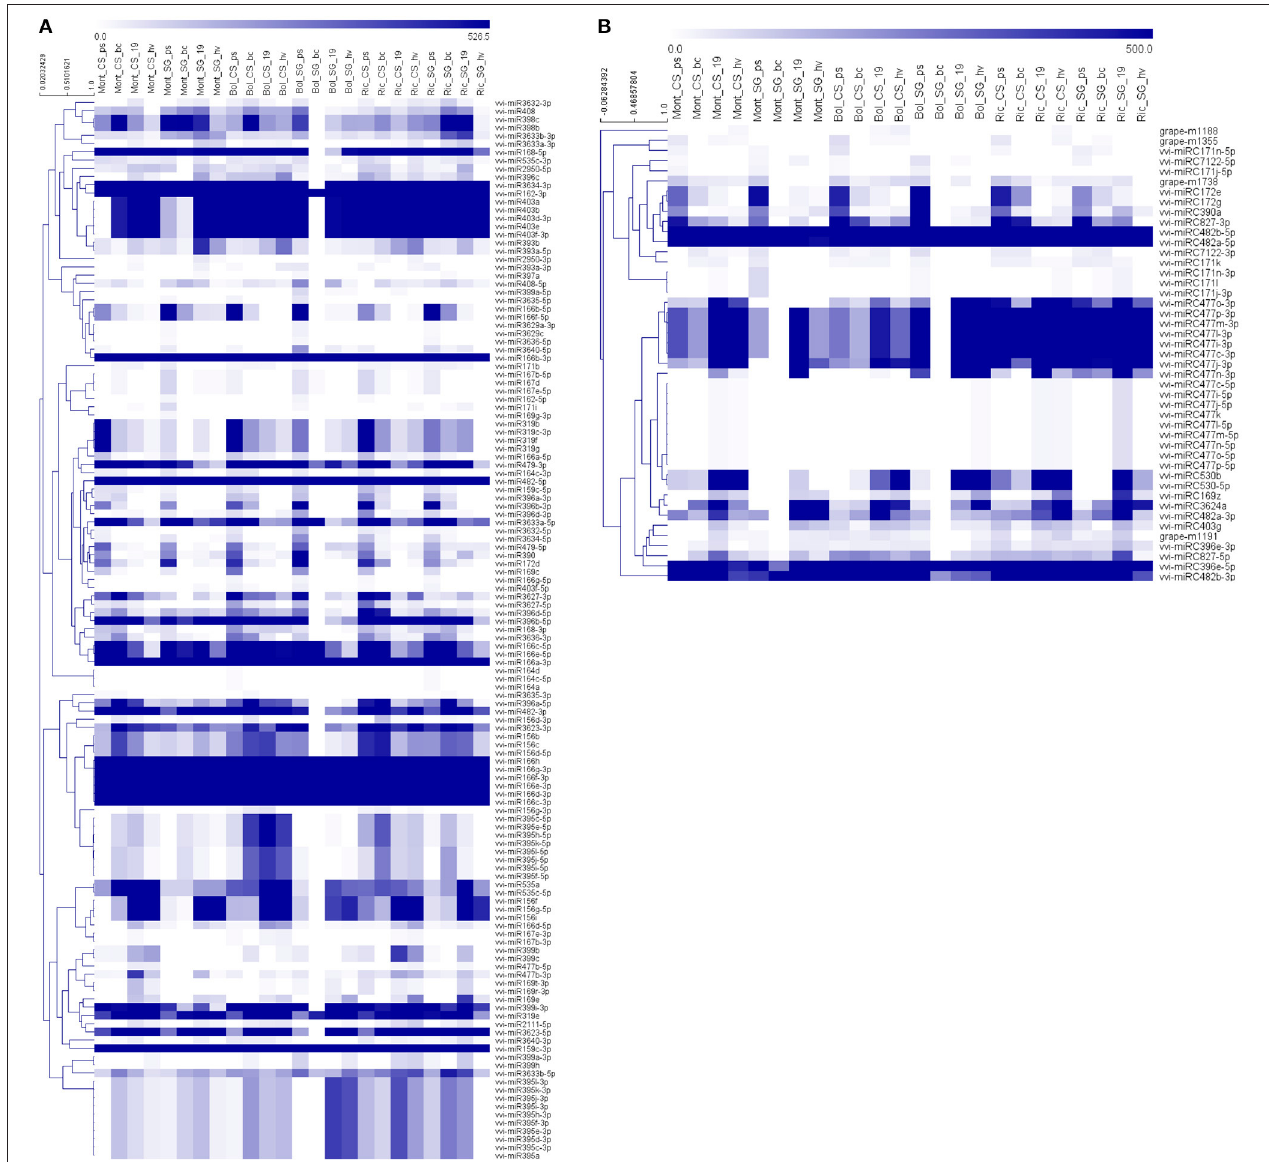
FIGURE 9 | Heatmap of hierarchically clustered (HCL) miRNAs, expressed in grapevine berries collected from 2 varieties in 4 developmental stages and growing in 3 vineyards. The HCL tree was generated with the average linkage clustering method. Blue and white represent high and low expression, respectively. Known and novel miRNAs are represented in two separated panels in order to reduce figures complexity (A) HCL of known miRNAs; (B) HCL of novel miRNA